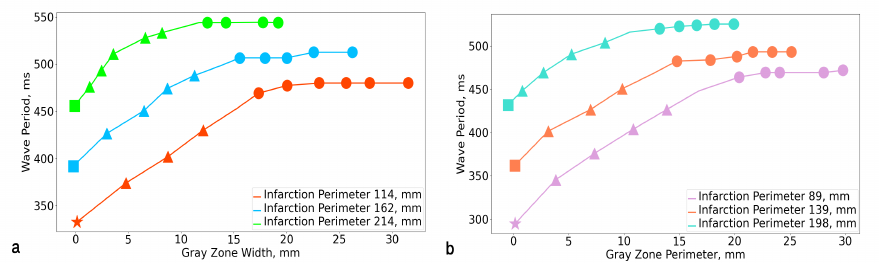
Figure 4. Dependence of the wave rotation period on the width of the gray zone in simulations with various perimeters of infarction scar. Here, and in the figures below, various symbols indicate wave of period at points where simulations were performed. A star indicates functional rotation , a triangle indicates gray zone rotation , a square indicates scar rotation , and a circle indicates scar rotation two . ( a ) Dependence for infarction perimeter 114 mm, 162 mm, and 214 mm. ( b ) Dependence for infarction perimeter 89 mm, 139 mm, and 198 mm.